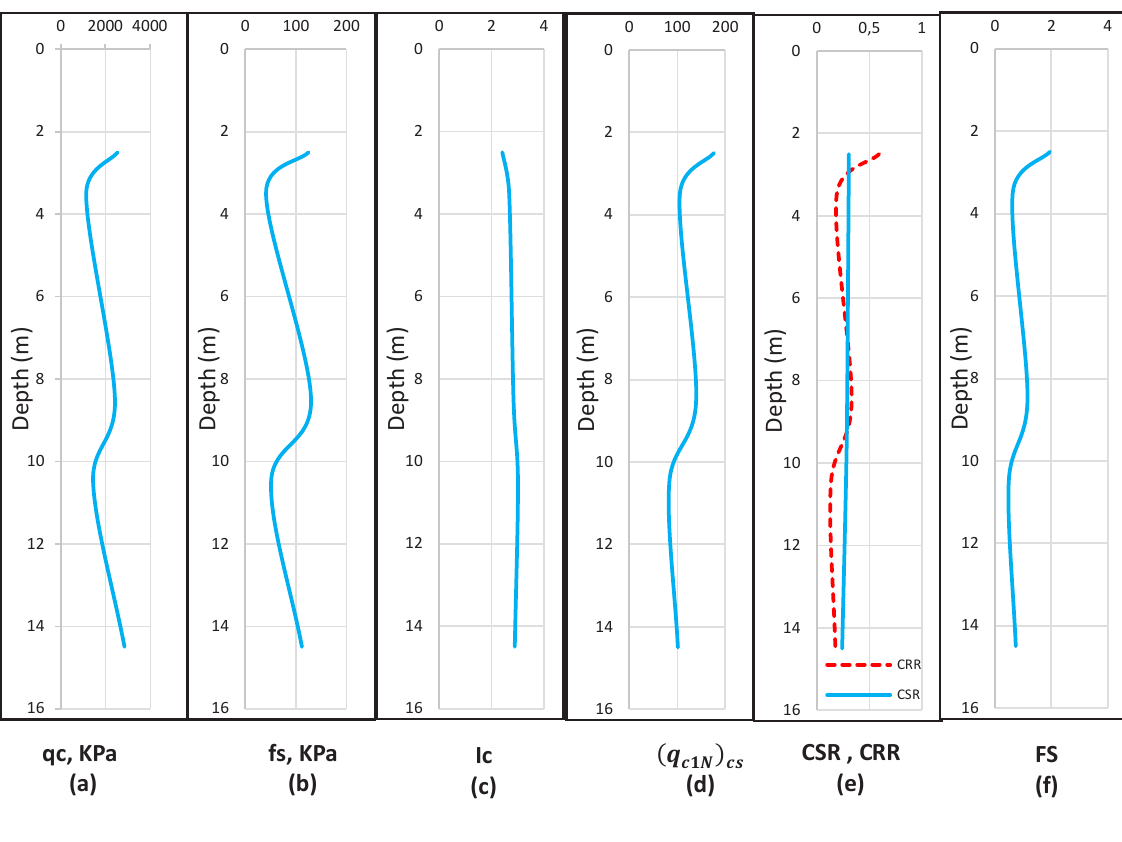
) ; (e) cyclic stress ratio (CSR) and cyclic resistance ratio (CRR); (f) factor of c 1 N cs